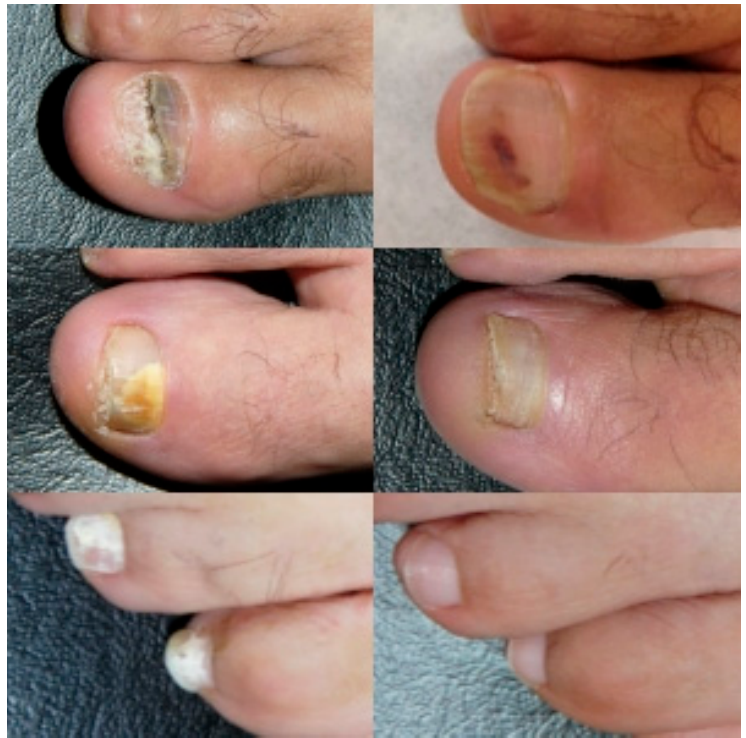
Figure 1. Clinical images of 3 patients before and after combined treatment with terbinafine and photodynamic therapy.